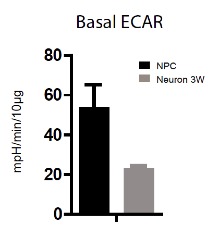
Extracellular acidification rate (ECAR) by Seahorse extracellular flux analysis on NPC and 3-week neurons.Error bars represent SD.